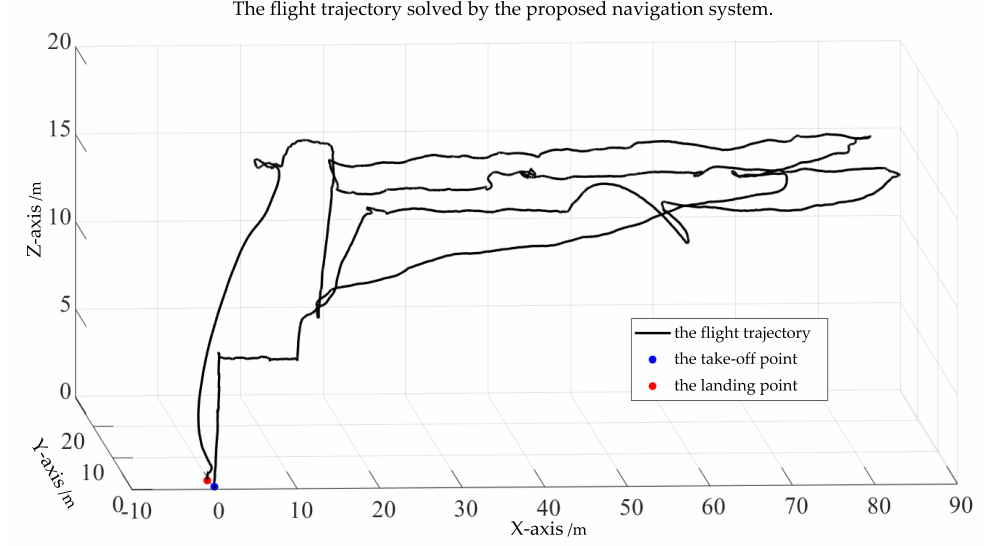
Figure 9. The flight trajectory solved by the proposed navigation system.